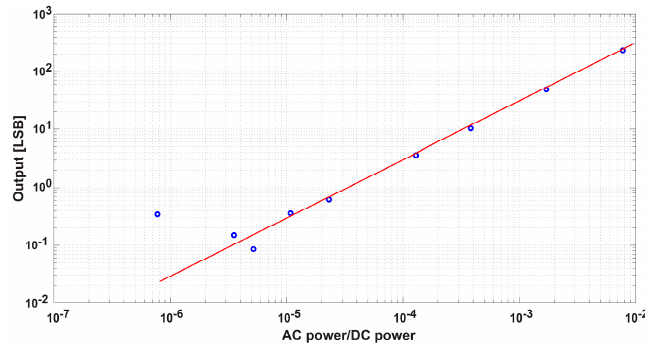
Figure 19. Small signal detection linearity.